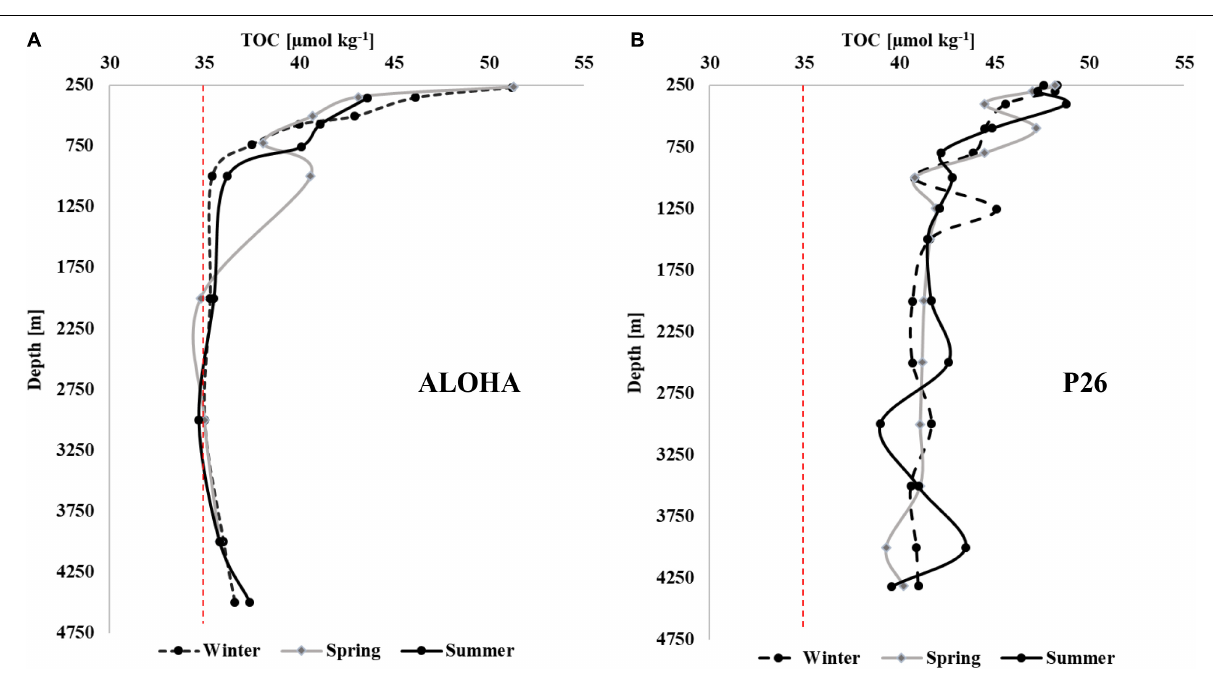
pattern in TOC between seasons for both years demonstrated an interannual